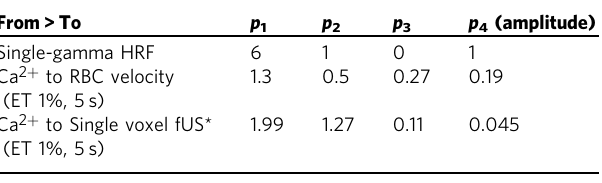
Table 1 Parameters of the different TFs computed in this